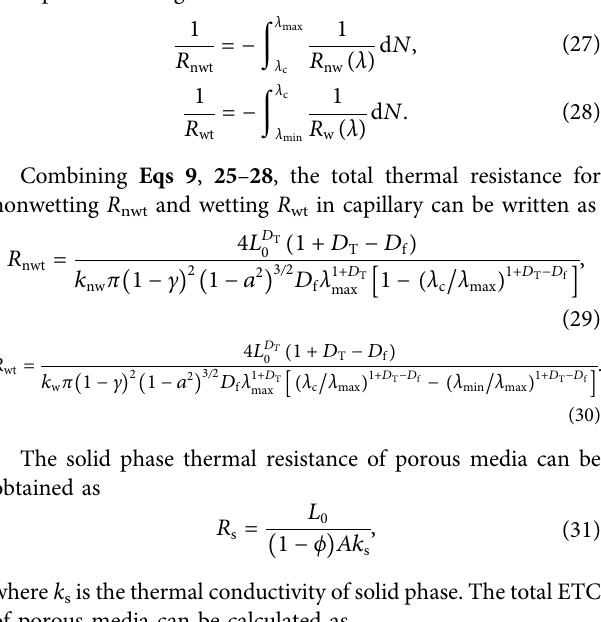
Frontiers in Earth Science |